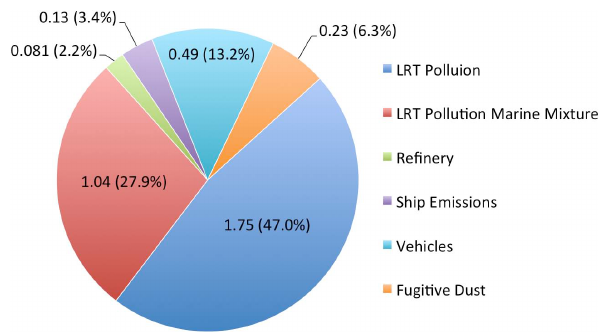
Fig. 12. Average mass concentration (µgm − 3 ) of attributed sources and percentage source contributions over the 45 days of